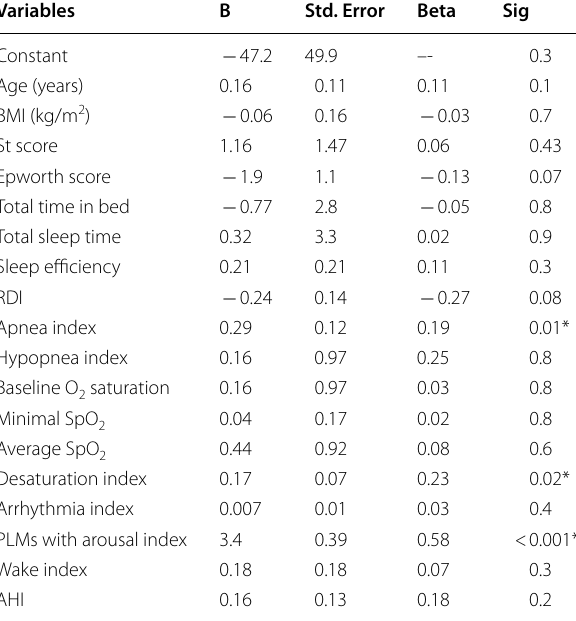
Table 5 Multivariate linear regression analysis to determine the prediction power of different parameters on